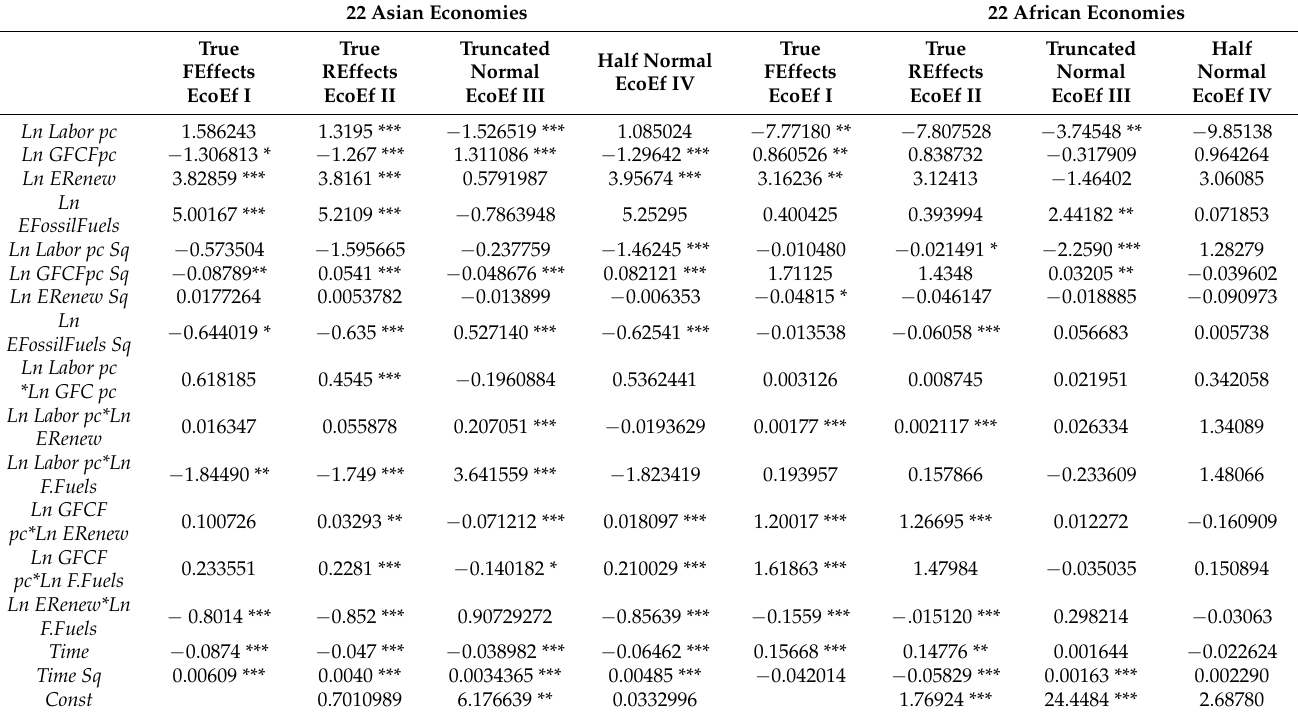
Table 1. Translog estimation results for Eco-efficiency with time-variant models (22 Asian countries and 22 African